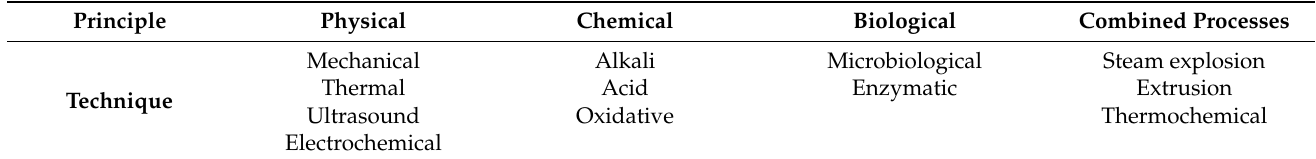
Table 1. General classification of pretreatment methods